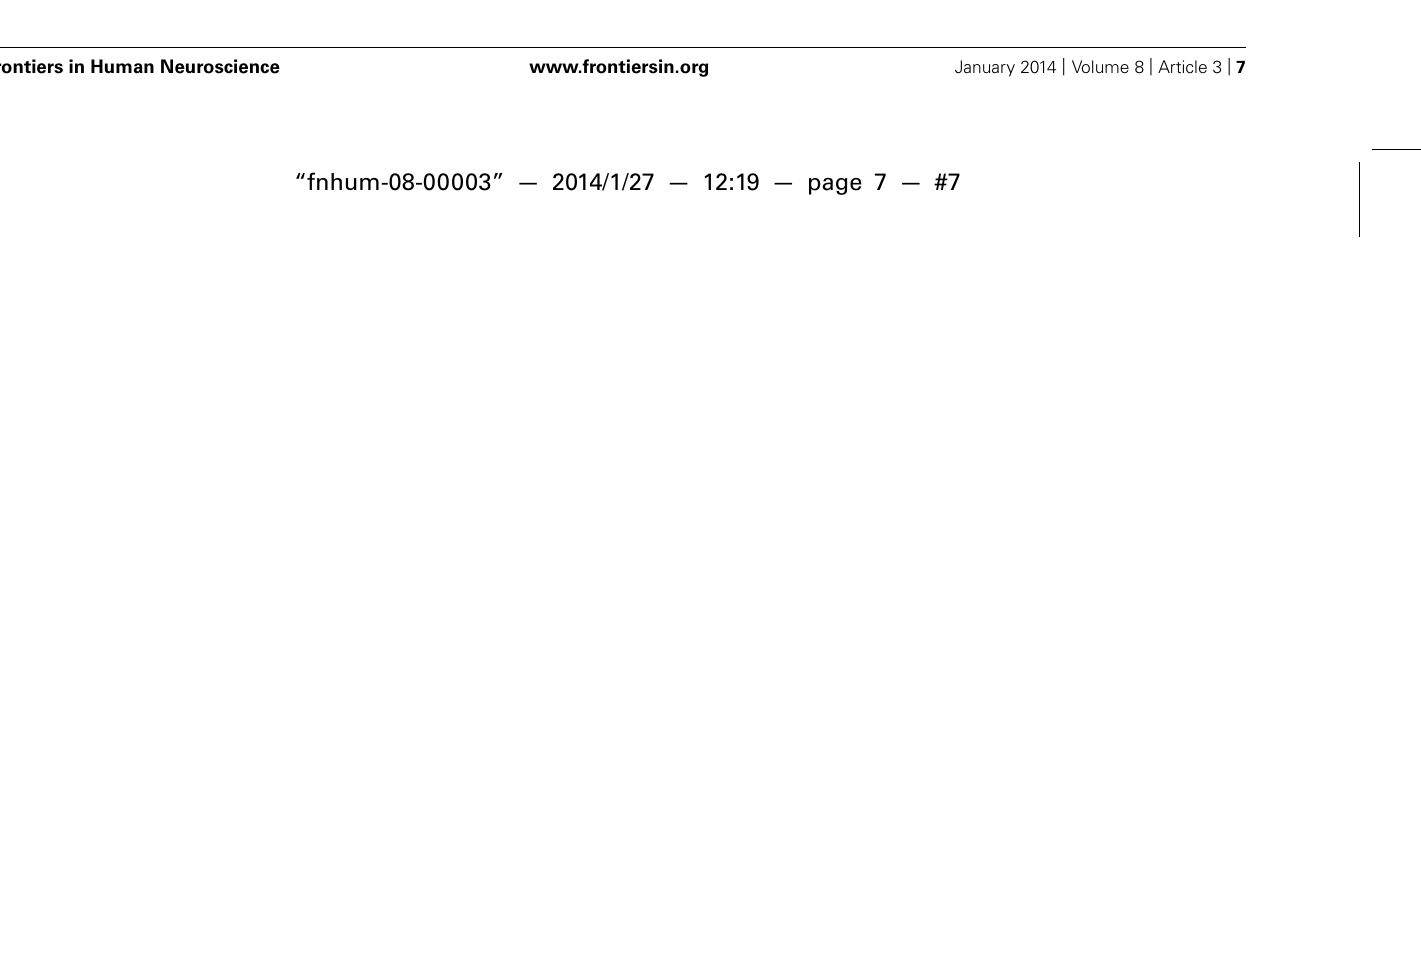
wasmorepronouncedwhenreachabilityjudgmentswereprovided relative to the pathological hand compared to the healthy hand ( p = 0.026and p = 0.028,respectively). Thus,RHpatientsrevealed a decrease of perceived peripersonal space when estimated accord- ing to both the healthy and hemiplegic arm, whereas LH patients revealedadecreaseof perceivedperipersonalspacewhenestimated according to the hemiplegic arm